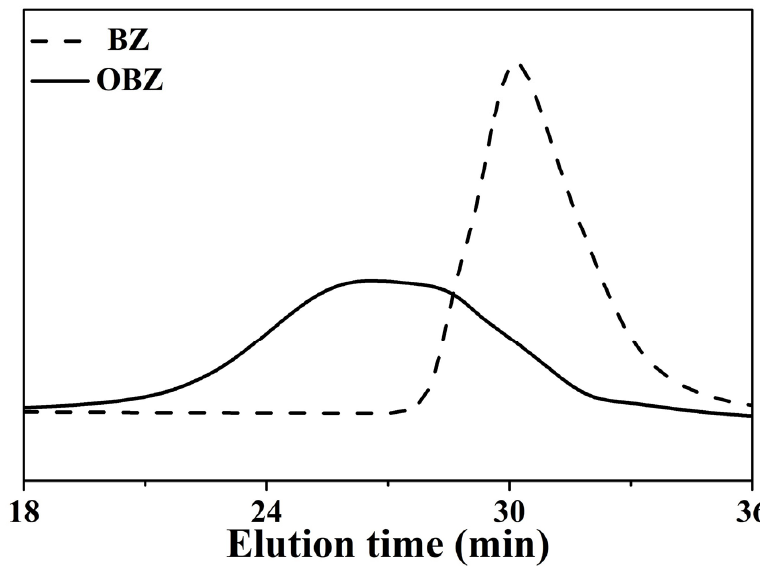
Figure 1. SEC chromatograms of OBZ and BZ.